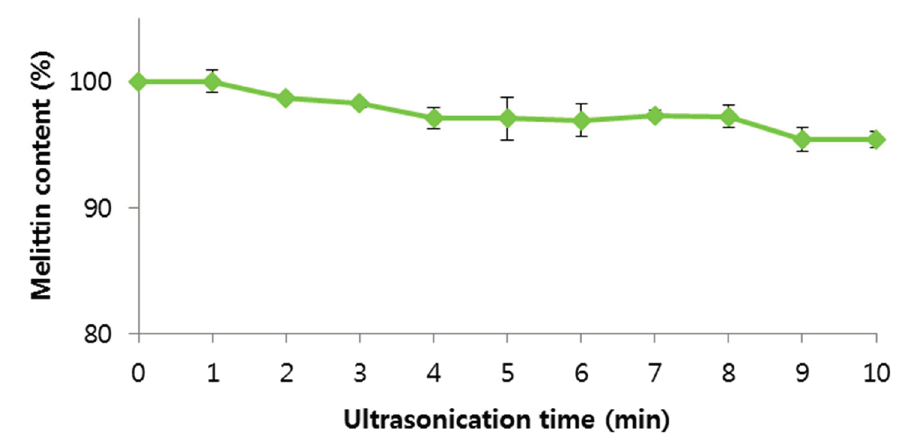
Figure 6. Effect of ultrasonication time on bee venom. Data are expressed as the mean ± SD ( n = 3).